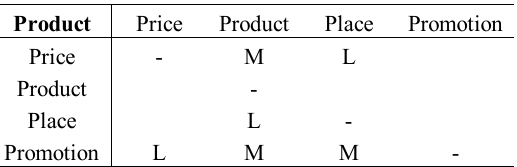
Table6. Pairwise comparisons of alternatives with respect to Product.